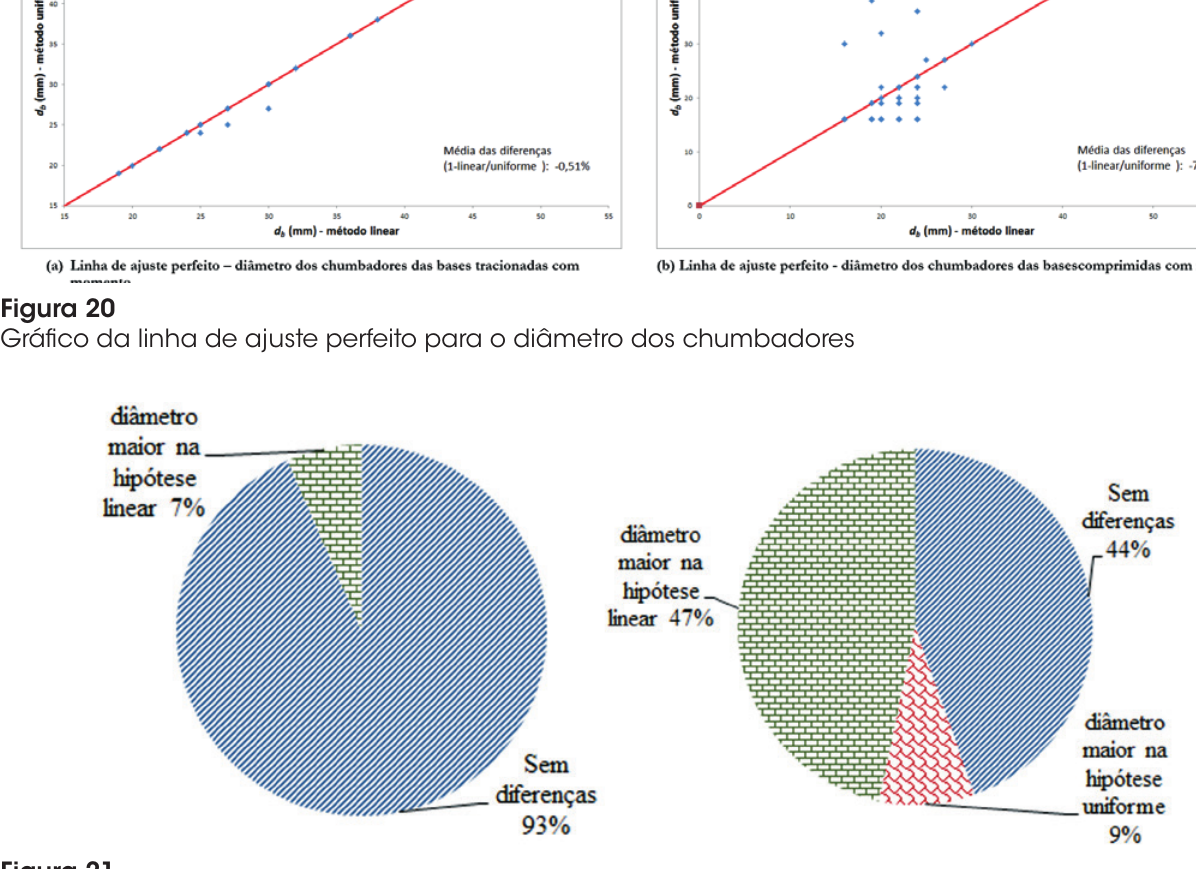
Figura 21 Comparação entre os métodos para o cálculo dos